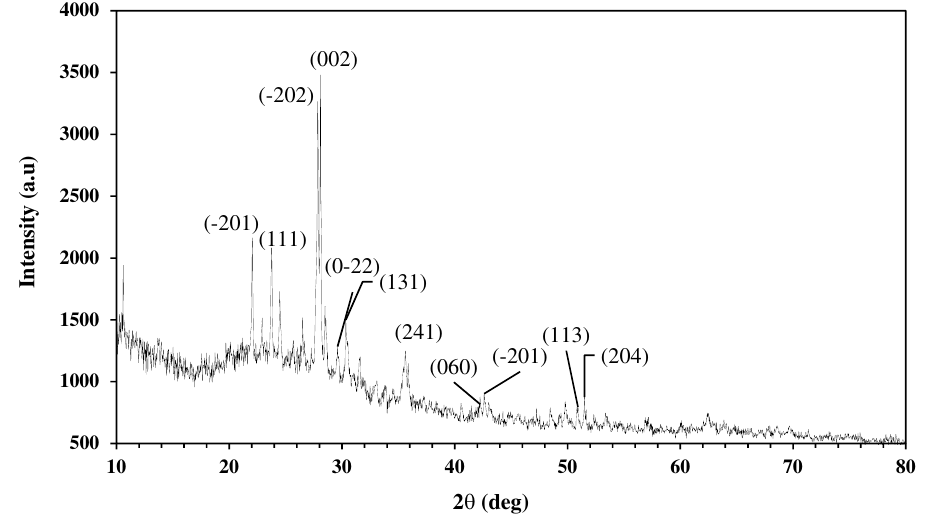
Figure 3. The XRD pattern of natural pumice.